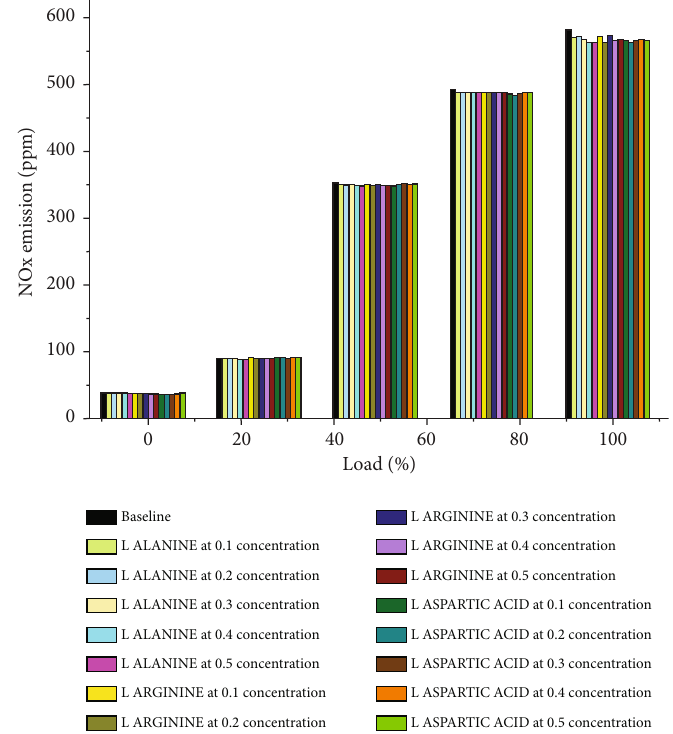
Figure 12: The di ff erence in NOx concentration with respect to engine